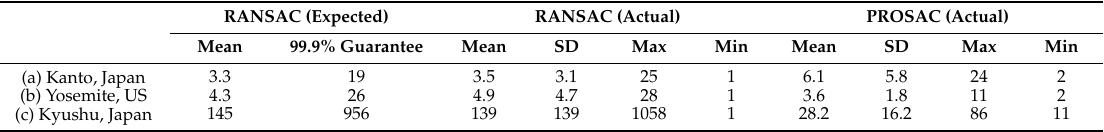
Table 5. Comparison of the expected and the actual repetition numbers with RANSAC and the actual repetition numbers with PROSAC for rejecting outliers embedded in the proposed framework. The “expected” column shows statistical expectations based on the analysis presented in Appendix B and the “actual” column shows actual values from 1000 trials. SD represents the standard deviation of repetition